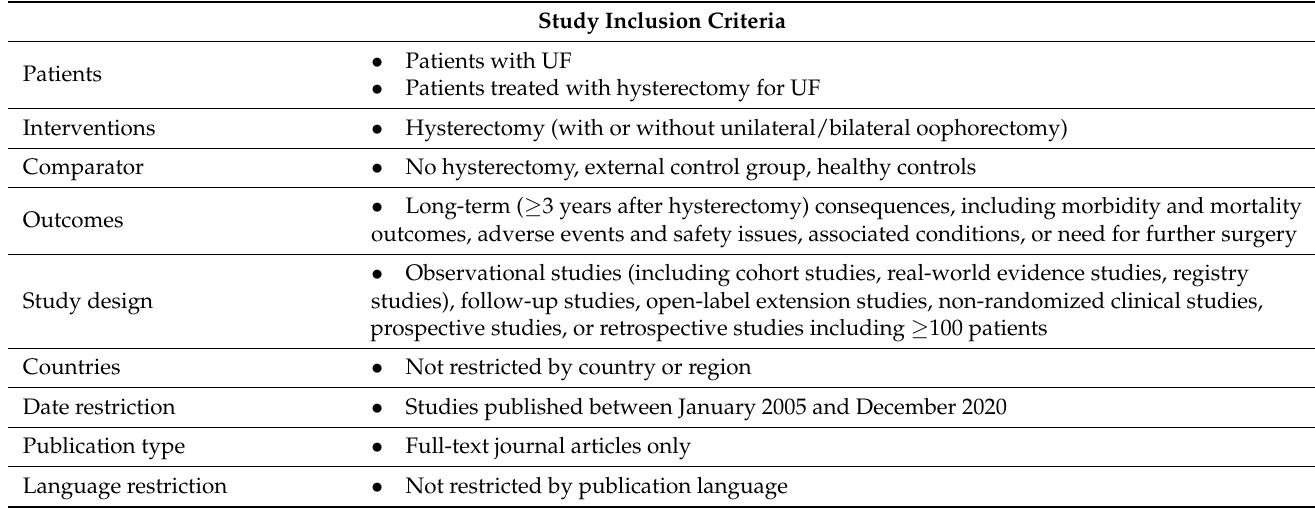
Table 2. Inclusion criteria used for selection of studies evaluating long-term consequences of